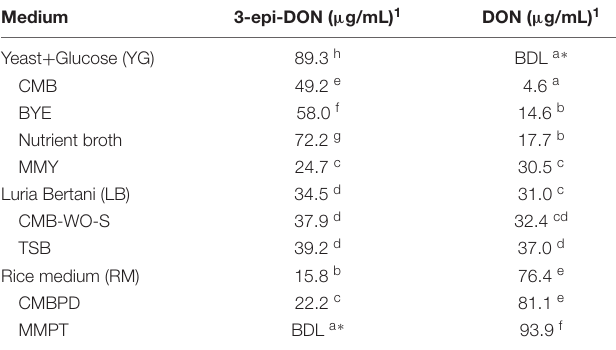
TABLE 3 | Residual DON and its bio-transformation products after culturing isolate 17-2-E-8 in different media preparations supplemented with 100 µ g/mL DON, at 28 ◦ C with continuous shaking at 200 rpm for 72